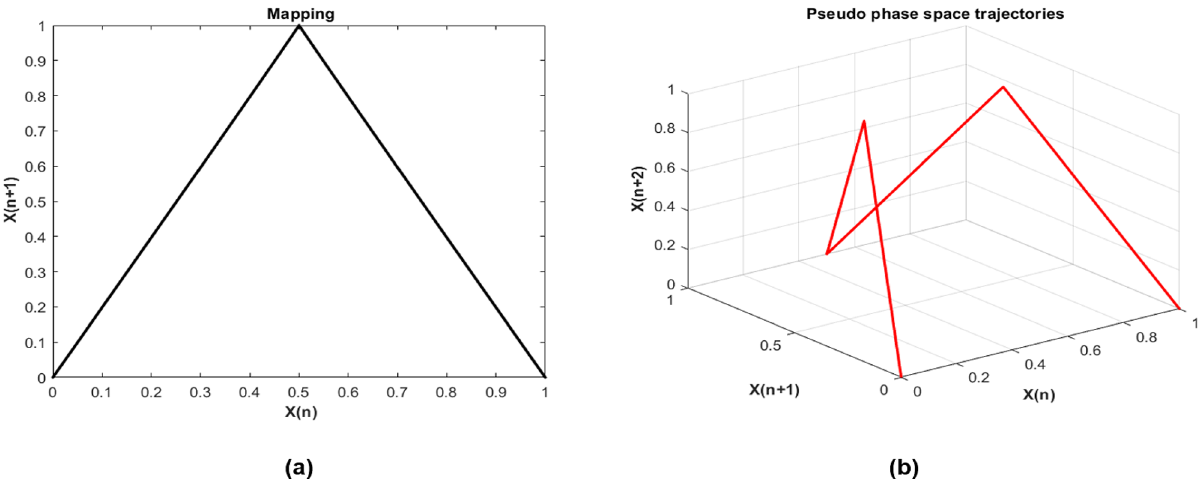
Fig. 1 Shows the a mapping and b pseudo phase space trajectory for first order symmetric chaotic map, also known as Tent